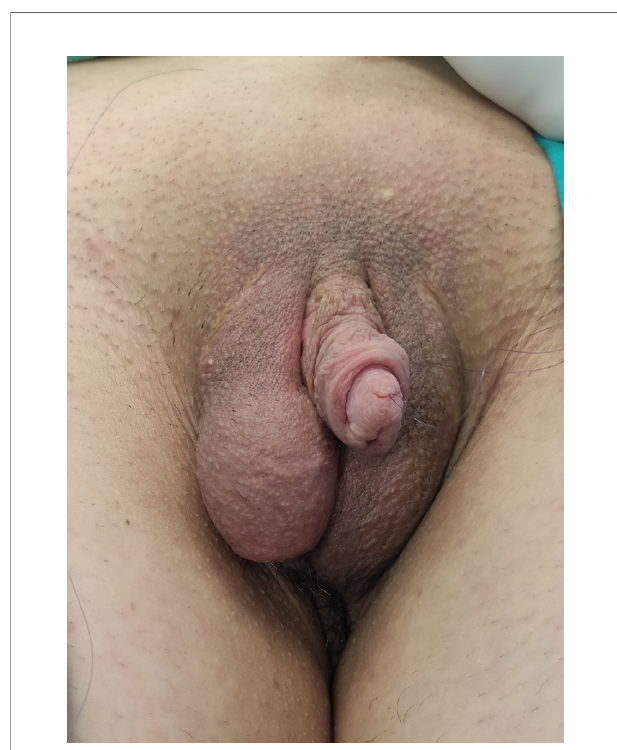
FIGURE 9 | Two years later, good penile length and aestetical outcome are achieved.